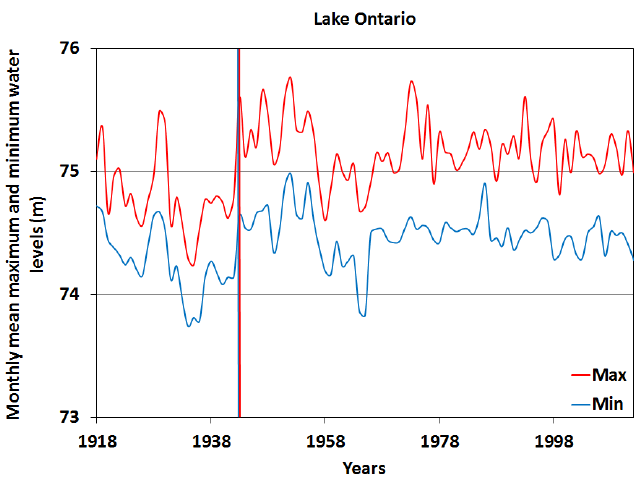
Figure 5. Temporal variability of monthly mean maximum ( red curve ) and minimum ( blue curve ) water levels in Lake Ontario (1918–2012). The vertical lines represent the timing of the shift in mean values of the series. Table 3. Lombard method results for monthly mean water levels in the North American Great Lakes over the period from 1918 to 2012. Analysis of variance